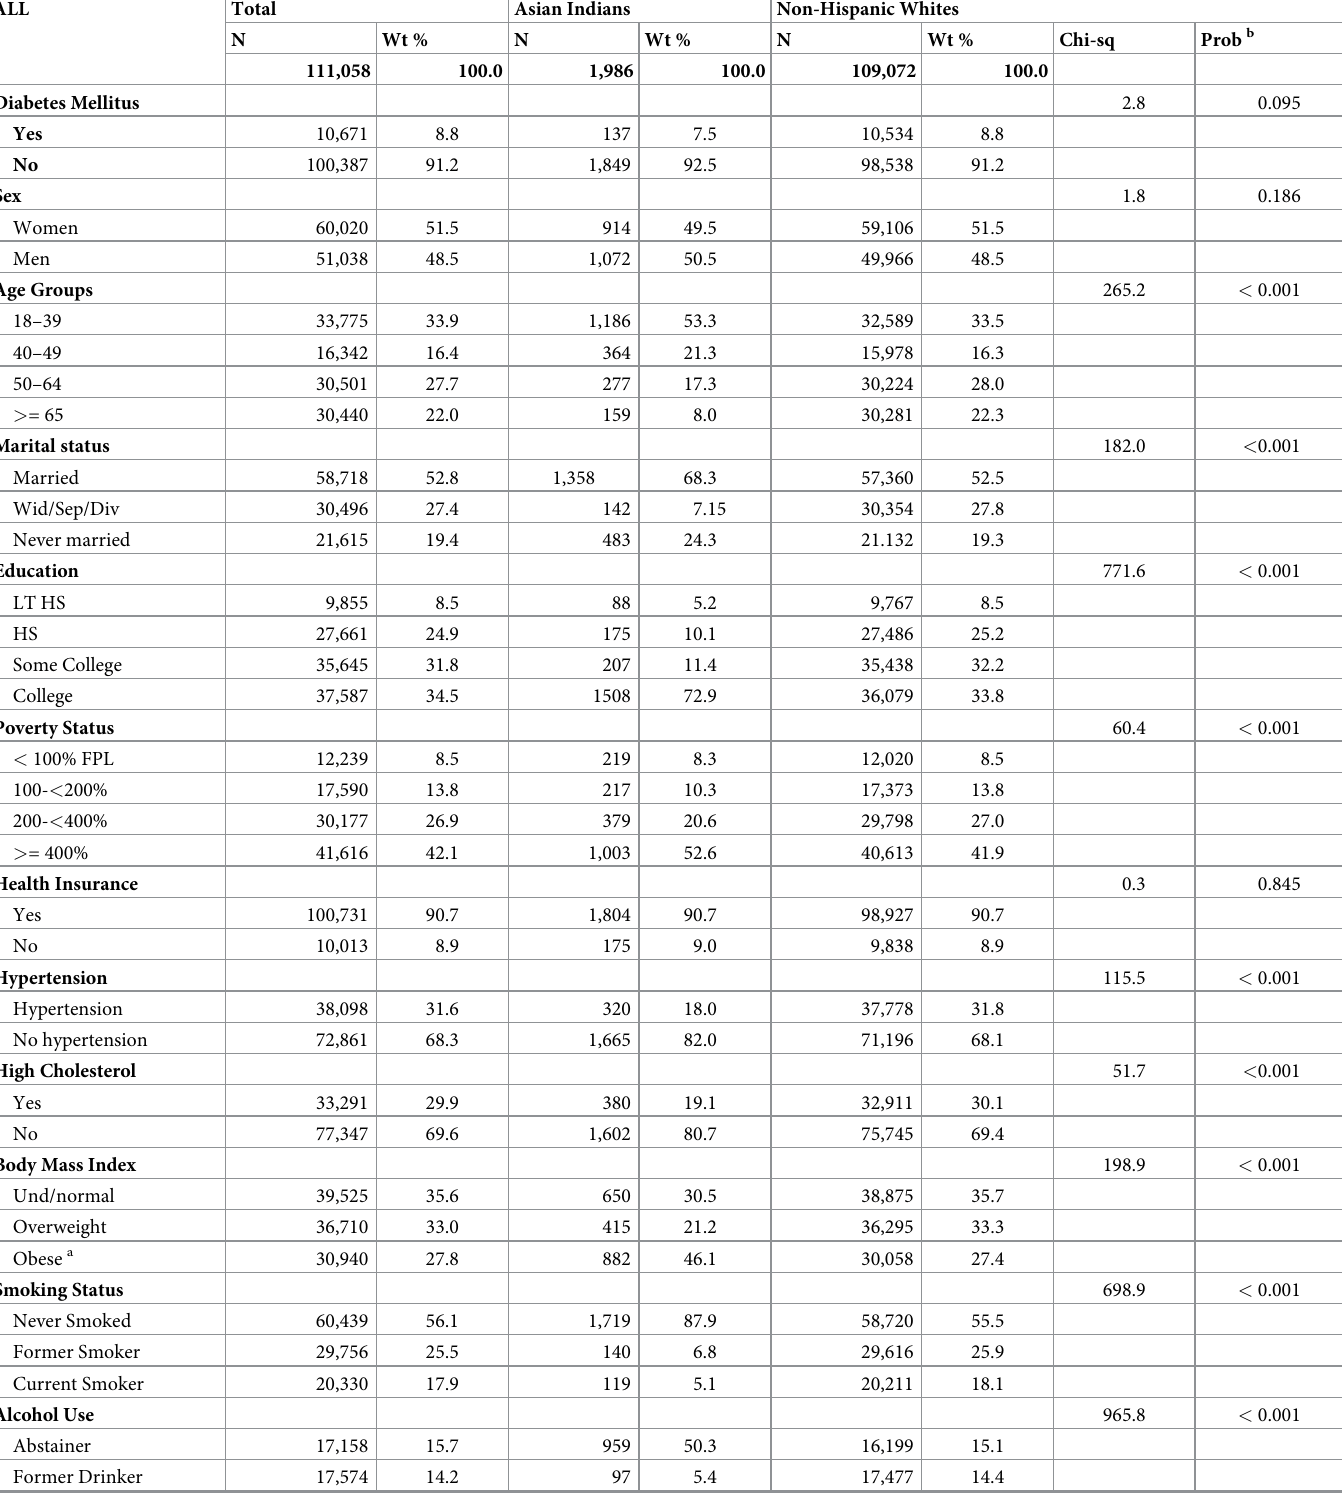
Table 1. Characteristics of Asian Indian and non-Hispanic White adults (n = 111,058), National Health Interview Survey, 2012–2016.